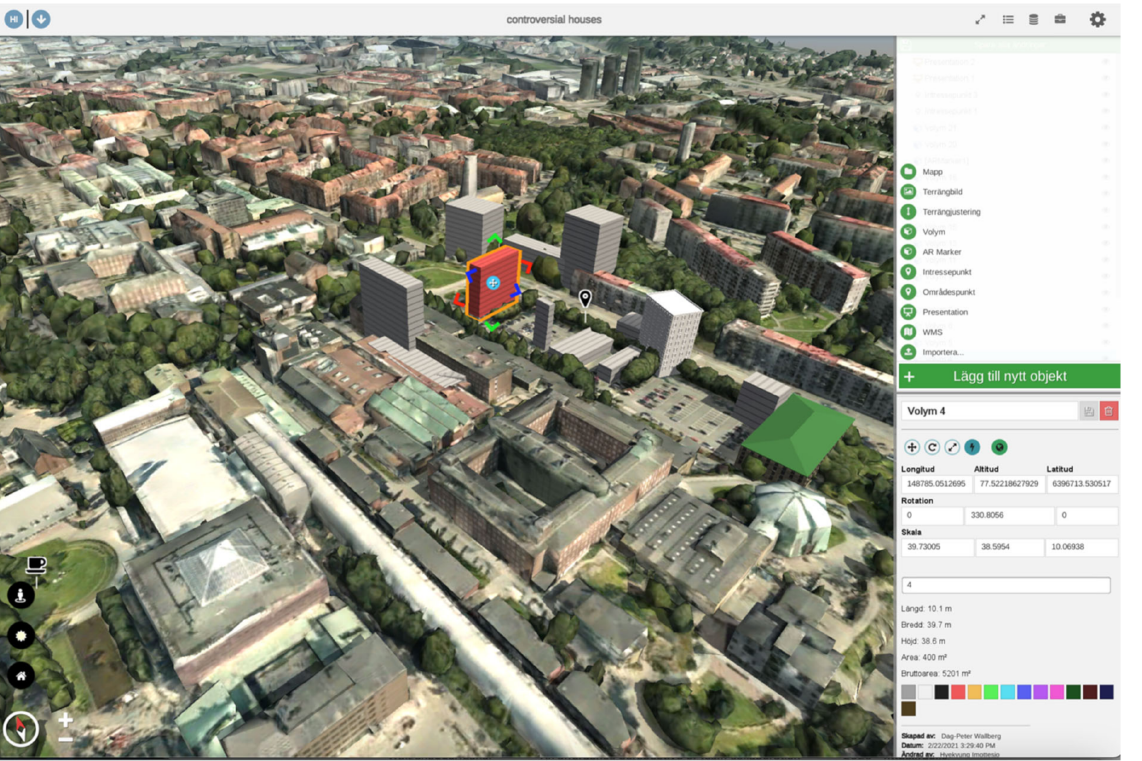
Figure 7. The volume function when placing objects, allowing users to place 3D cubes which can be